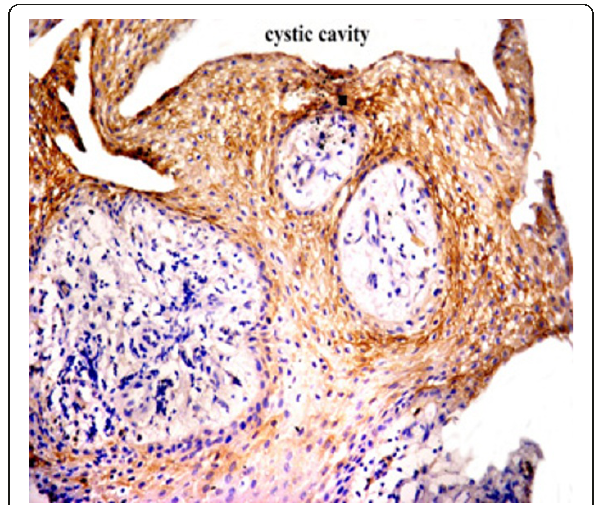
Figure 2 Photomicrograph of intraluminal UCA showing cytoplasmic & membranous reaction of central cells of epithelial strands (red arrow) (Anti-CD10. Original magnification x40) .